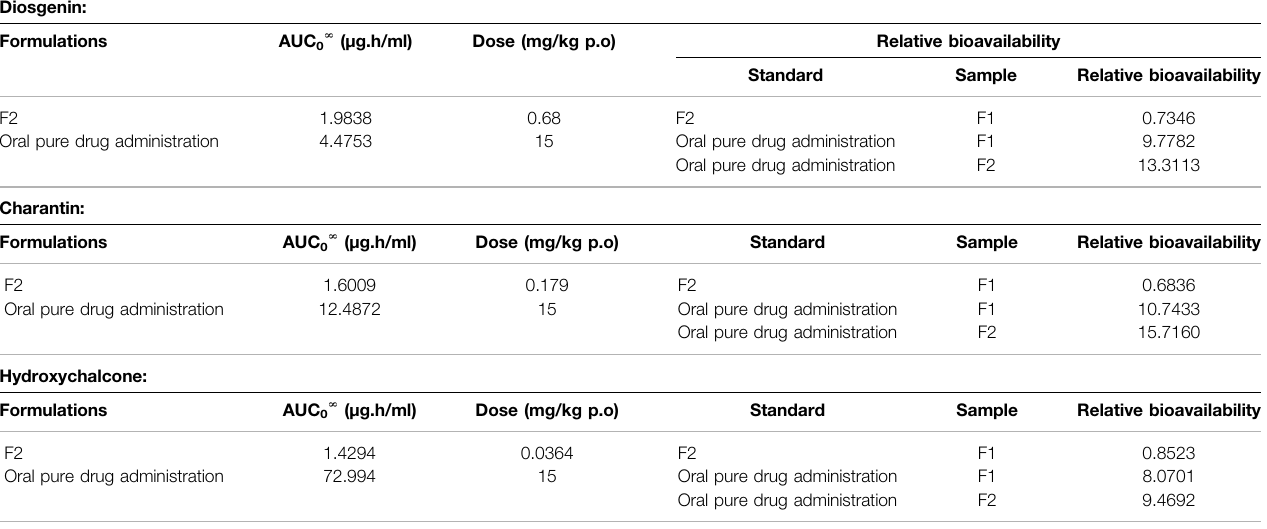
TABLE 9 | Relative bioavailabilities of diosgenin, charantin, and hydroxychalcone in the formulation without piperine (F1), formulation with piperine (F2), and oral pure drug